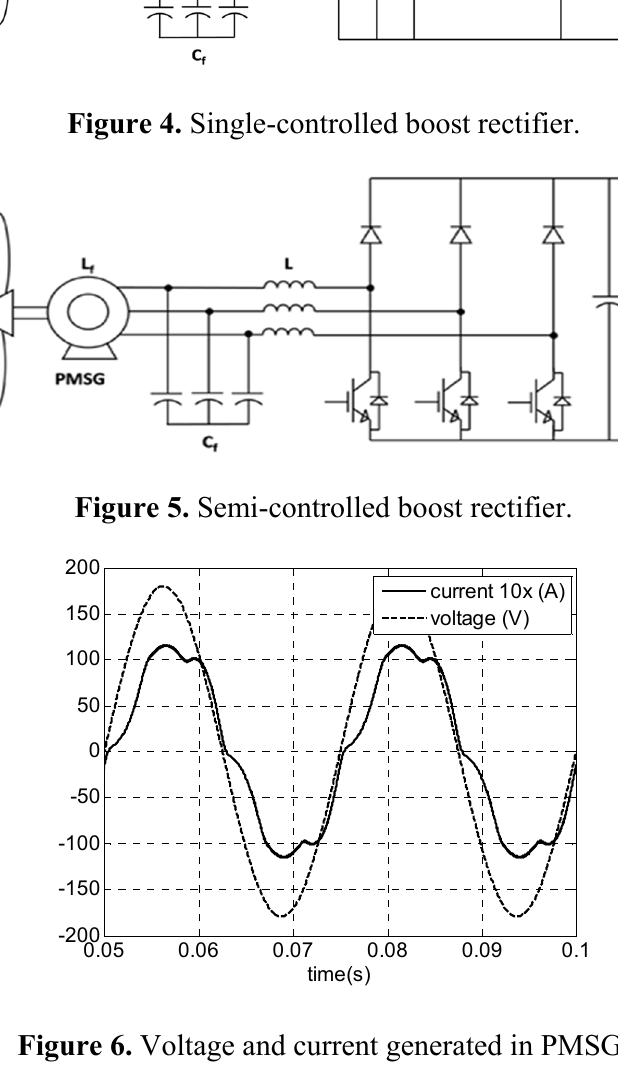
Figure 6. Voltage and current generated in